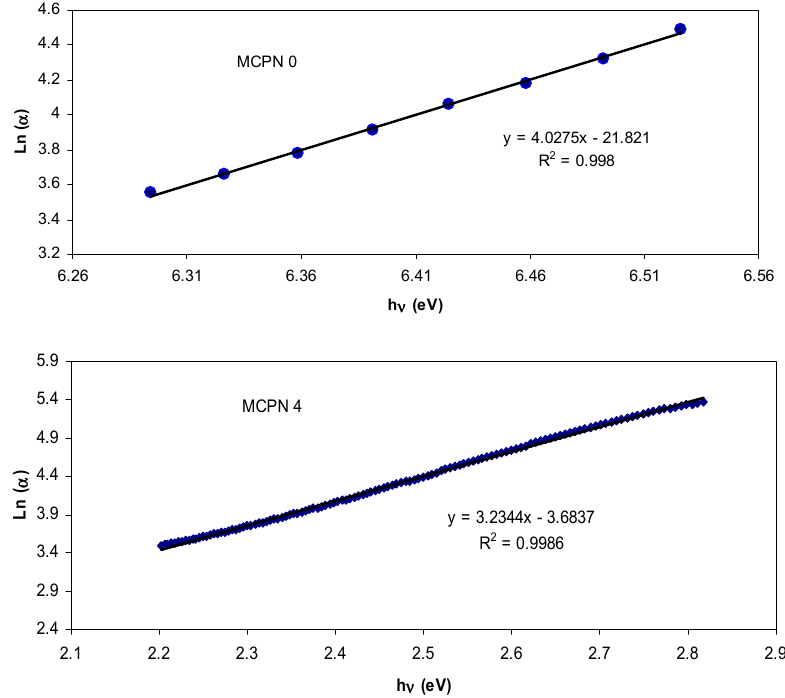
Figure 10. Urbach plots for pure MC (MCPN0) and doped MC (MCPN4) samples.